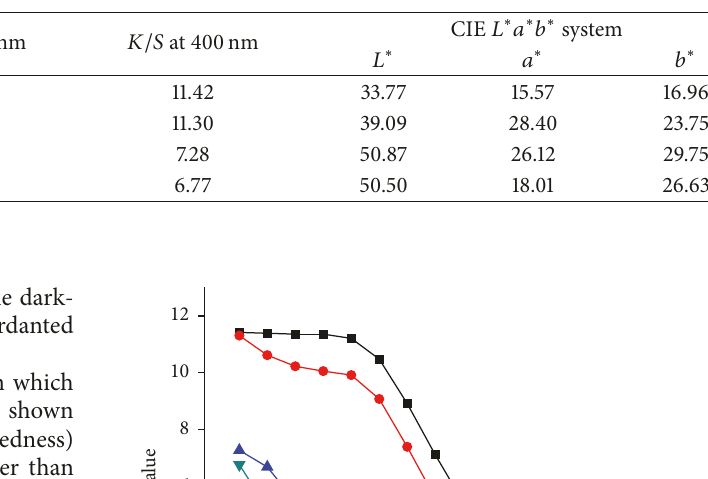
Table 3: Color strength (𝐾/𝑆) value, reflectance (%), and CIE 𝐿 ∗ 𝑎 ∗ 𝑏 ∗ values of selected dyed leather samples.